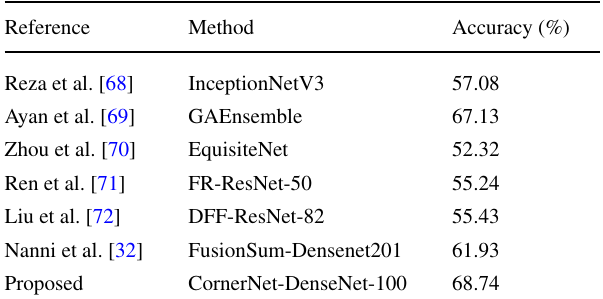
Table 8 Performance comparison of the proposed method with existing